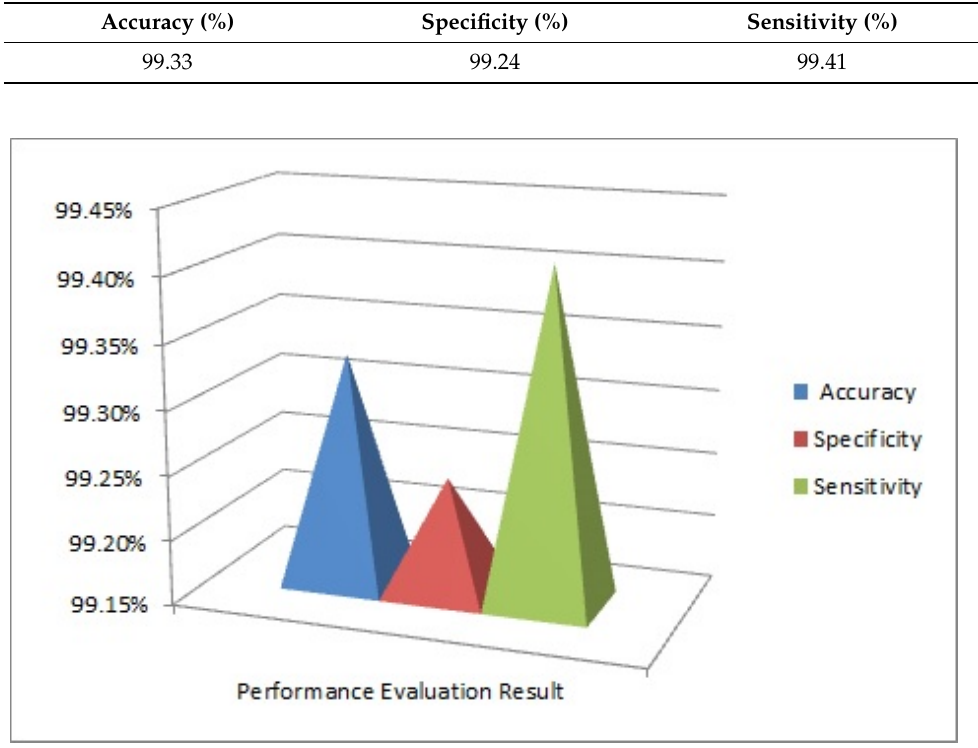
Figure 26. Chart presentation of performance evaluation